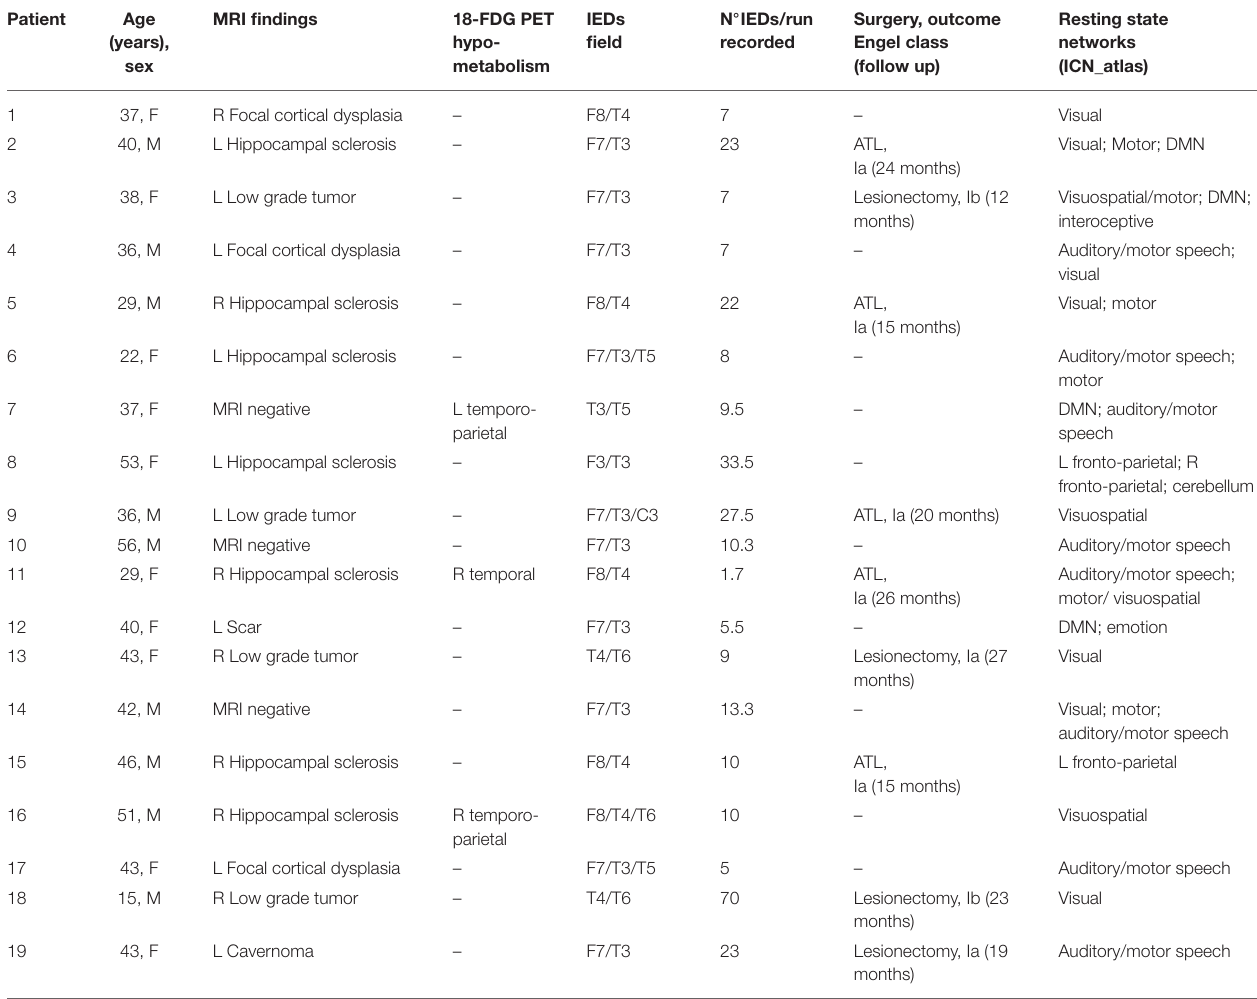
TABLE 2 | Electro-clinical and radiological features of 19 patients with positive fMRI results.